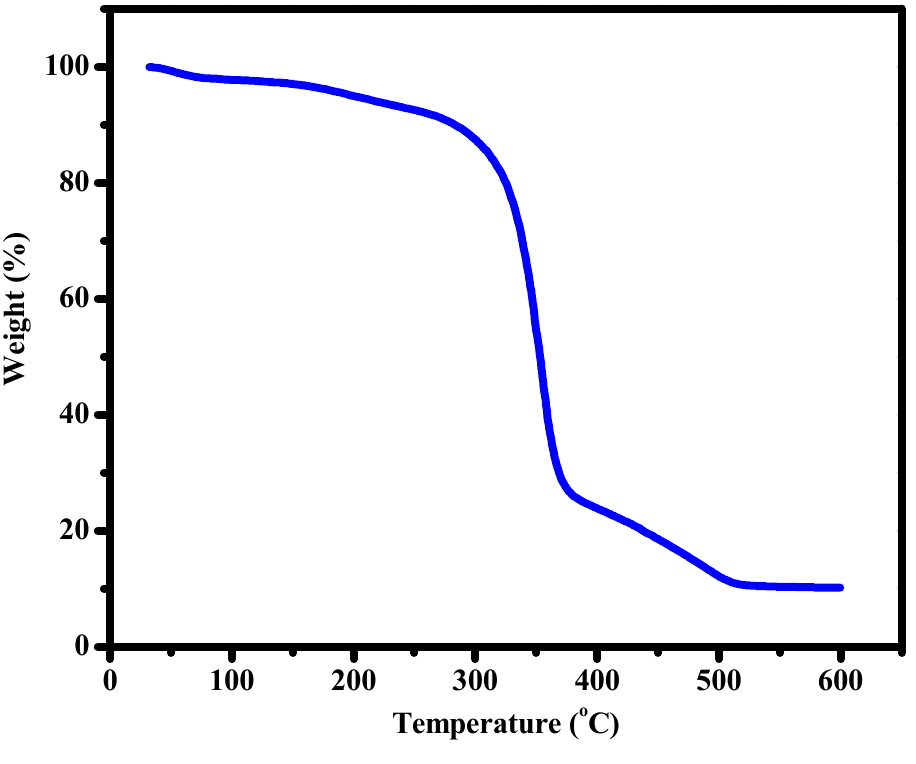
Figure 5. The TGA analysis for the final Ag 2 O/ZnS/GO/CA composite from room temperature to 600 °C.